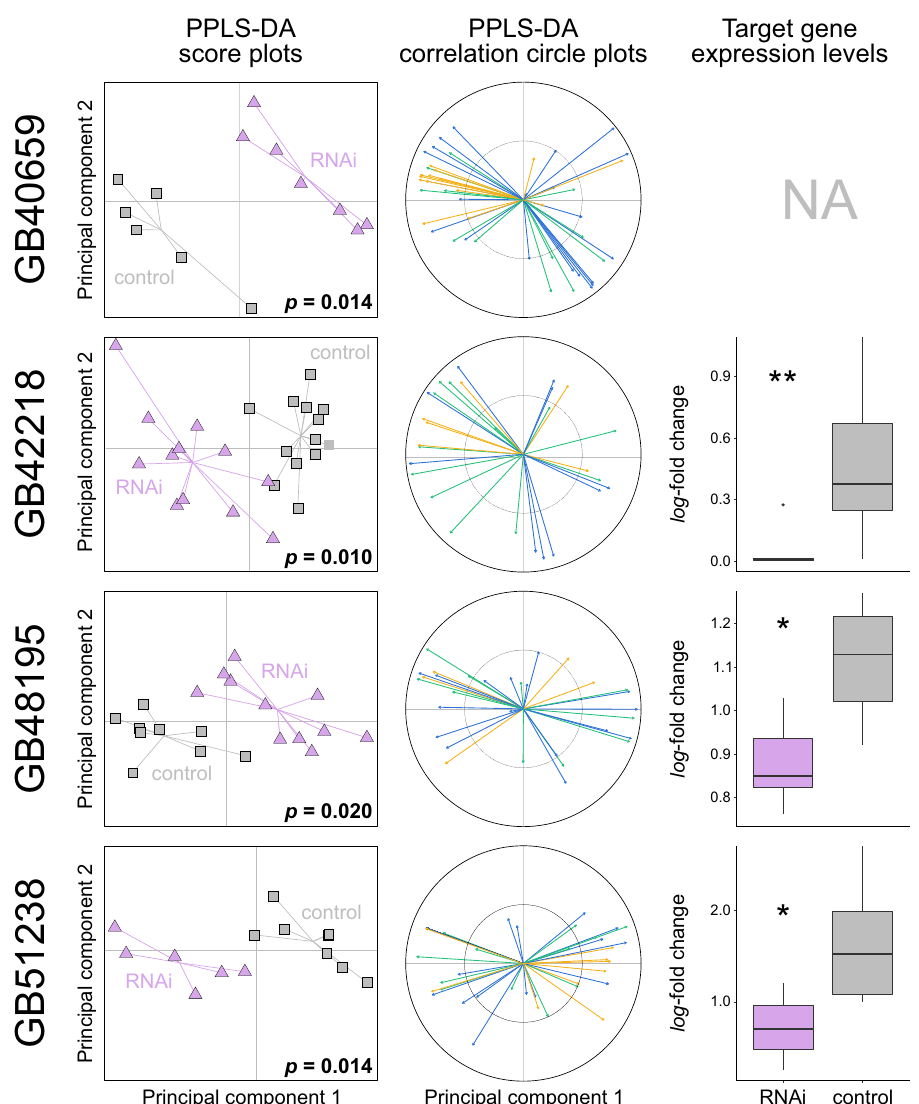
Fig. 6 Effects of RNAi-mediated knockdown of four fatty acid desaturases in worker honey bees ( Apis mellifera ) 2 – 5 days after dsRNA treatment. The fi rst two columns show score plots and correlation circle plots from a powered partial least squares discriminant analysis (PPLS-DA) of cuticular hydrocarbon (CHC) pro fi le data of target gene-treated (in purple: GB40659 , GB42218 , GB48195 , GB51238 ) and of control bees (in grey, injected with dsRNA targeting GFP). P -values indicate the statistical probability of group differences representing random variation after Benjamini-Hochberg correction for multiple ( N = 10) testing. The correlation circle plots indicate how many CHCs of a given compound class (i.e., alkanes [green], alkenes/alkadienes [blue], methyl-branched alkanes [yellow]) correlate with the fi rst two principal components. Box plots in the third column show gene expression levels ( log 2 -fold change) of the target genes in target gene-treated (in purple) and in control bees (in grey). Asterisks indicate the statistical signi fi cance of expression differences between target gene-treated and control bees after applying Benjamini-Hochberg correction for multiple testing ( N = 9; Welch ’ s